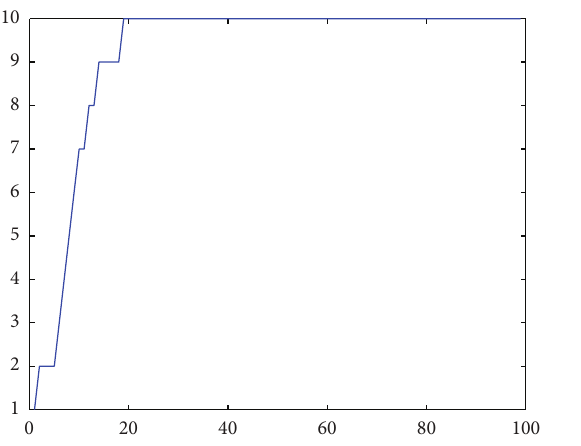
Figure 8: System output cell trajectory.